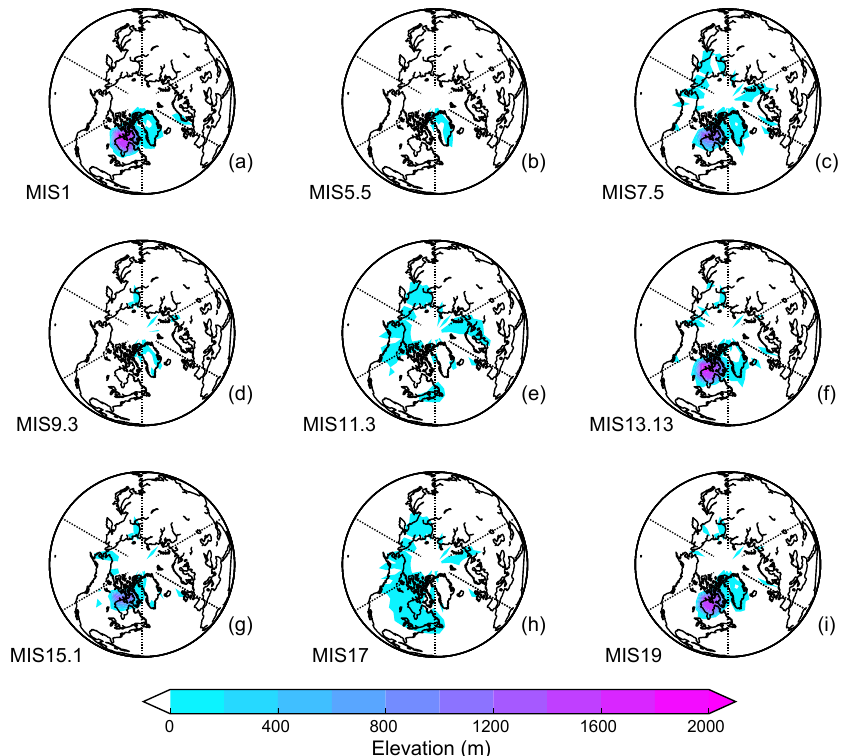
Figure 2. Ice sheet elevation (m) in the Northern Hemisphere simulated by the CLIMBER-2 model (Ganopolski and Calov, 2011) and used in the OVIC series for each interglacial simulation, in anomalies with respect to the pre-industrial elevation. Table 2. Summary of the three series of simulations. Name of the series Components impacting the carbon cycle Ocean Vegetation Different interglacial ice